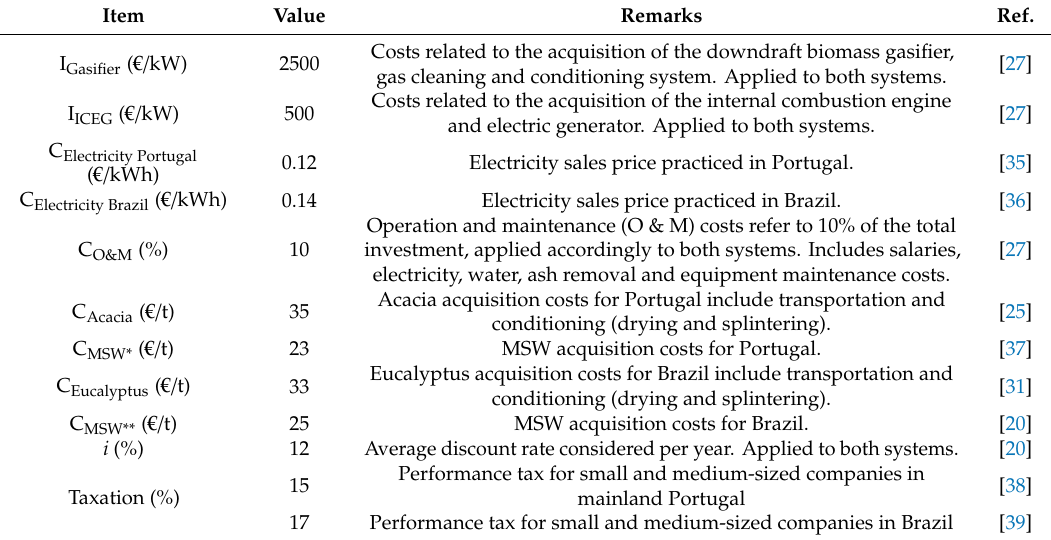
Table 6. Main economic assumptions for the Portuguese and Brazilian proposed